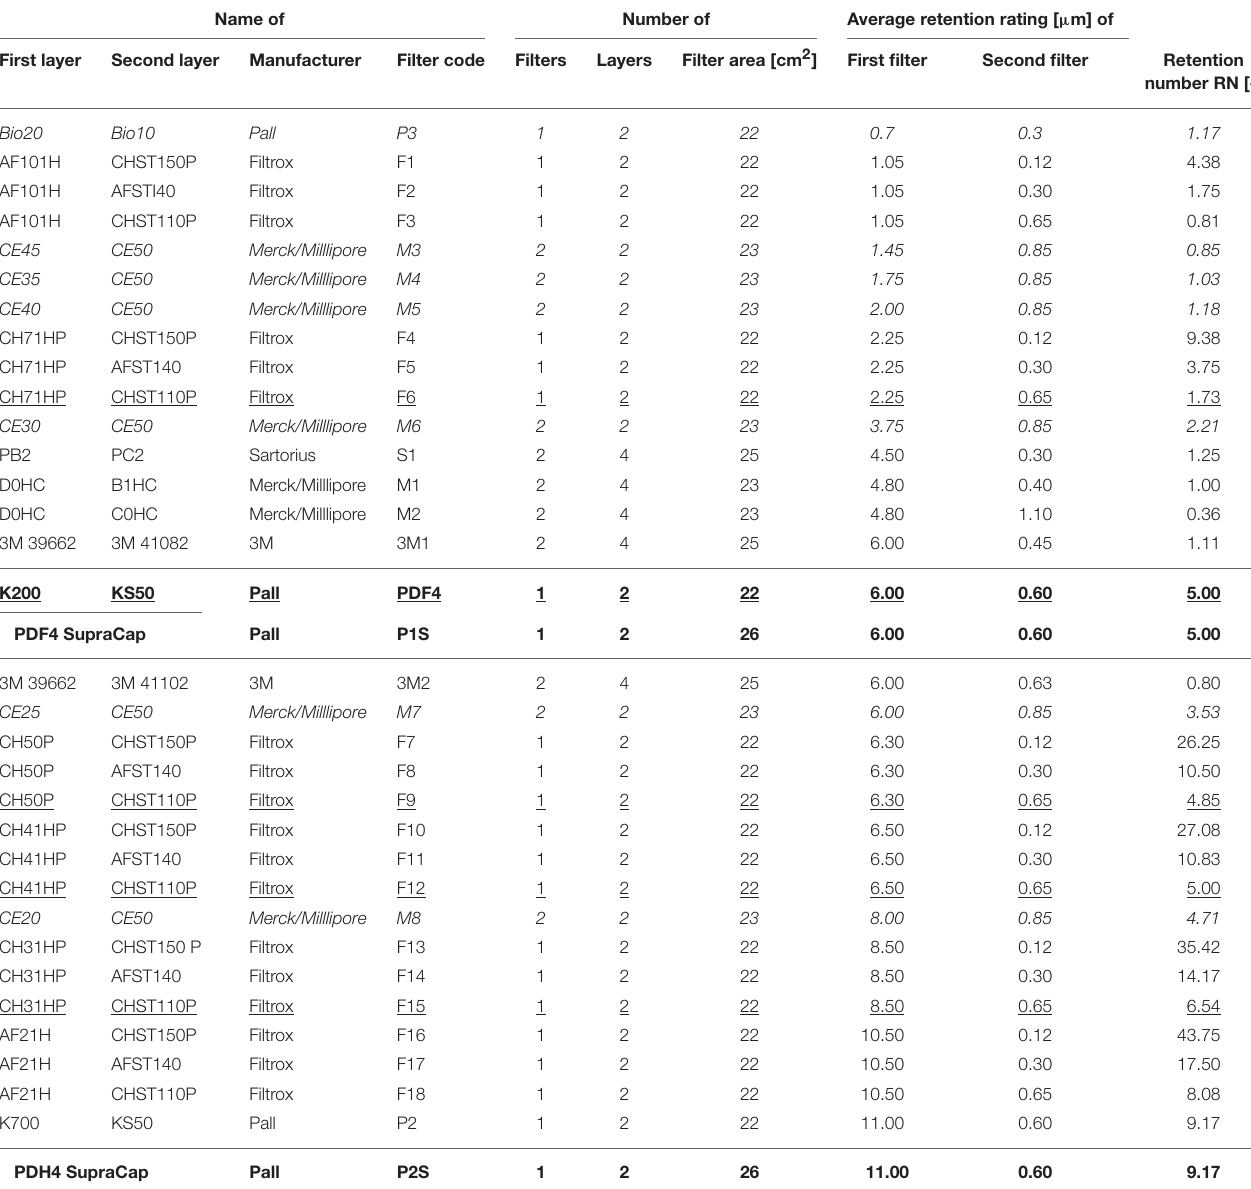
TABLE 1 | Depth filters tested for the clarification of bag-filtered plant extract in ascending order of retention rating. Name